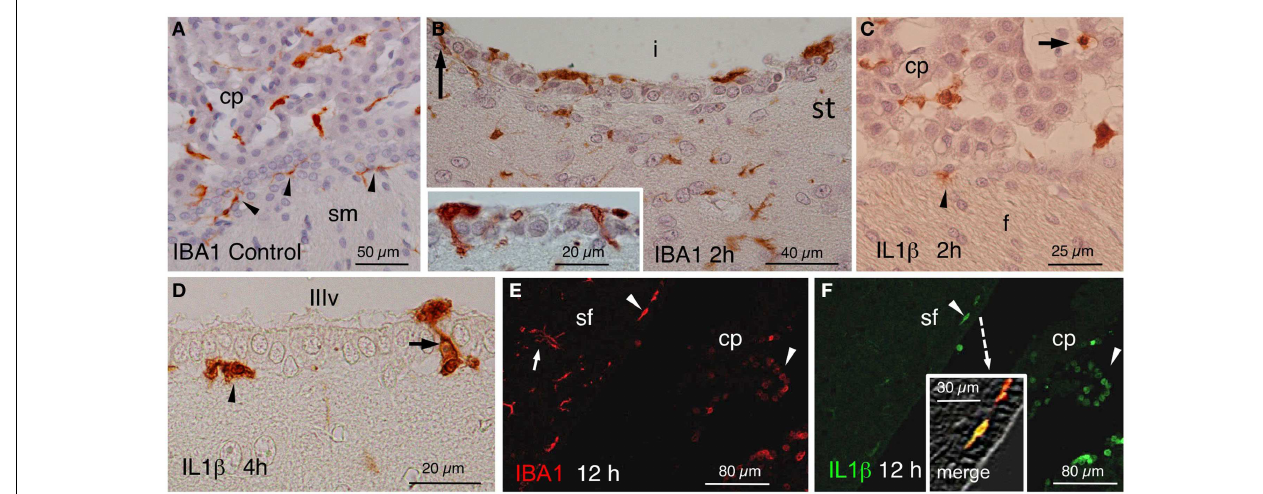
(arrowhead) and crossing the ependymal wall (arrow) of the third ventricle (IIIv) 4h after the injection of NA. (E,F) Double immunofluorescence with anti-IBA1 (red) and anti-IL1 β (green). Double-stained cells appear in the ventricle and the subependyma (arrowheads, and merge detailed in the inset of (F) showing a double-stained subependymal cell). Many IBA1-positive cells in the brain parenchyma were not immunoreactive to IL1 β [arrow in (E) ]. cp, choroid plexus; sf, septum-fimbria; sm, stria medullaris; (i), injected lateral ventricle; st, striatal wall of the lateral ventricle; f, fornix; IIIv, third